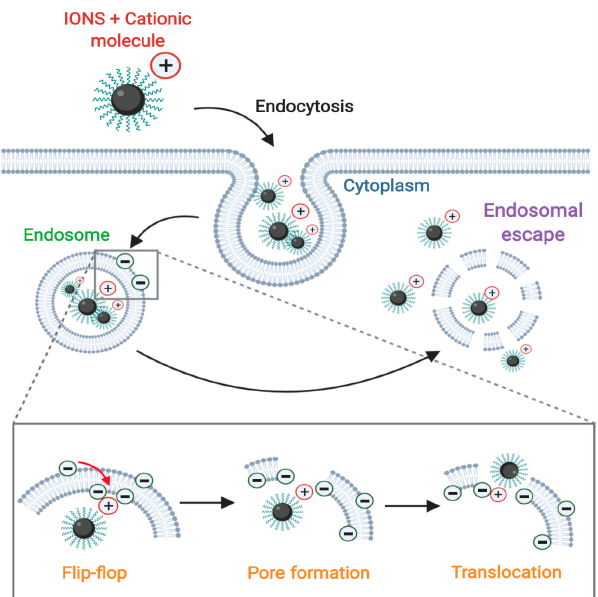
Figure 5. Schematic illustration of the translocation mechanism. Nanoparticles (IONS coated with cationic molecules) are endocytosed by the cell and internalized inside endosomes. The positive charge of the coated nanoparticles generates a flip-flop of the endosome’s cytosolic anionic lipids, which induces the generation of pores through which the nanoparticles can cross the endosomal membrane to reach the cytosol. (Created with BioRender.com).